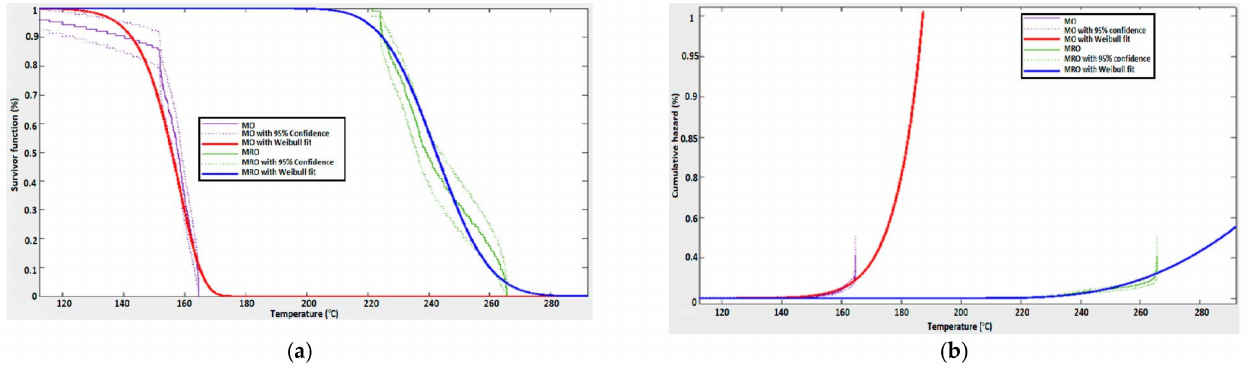
Figure 26. Flash point of MRO and MO with ( a ) survival, ( b ) hazard function with 95% confidence interval fitted to the